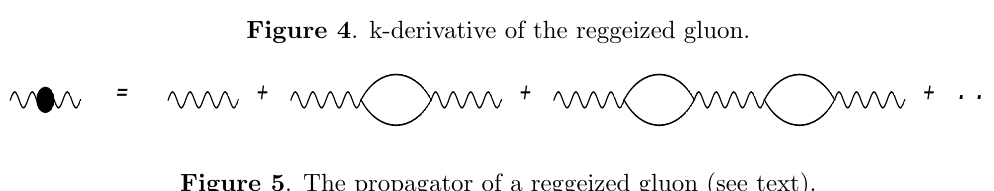
Figure 4 . k-derivative of the reggeized gluon.